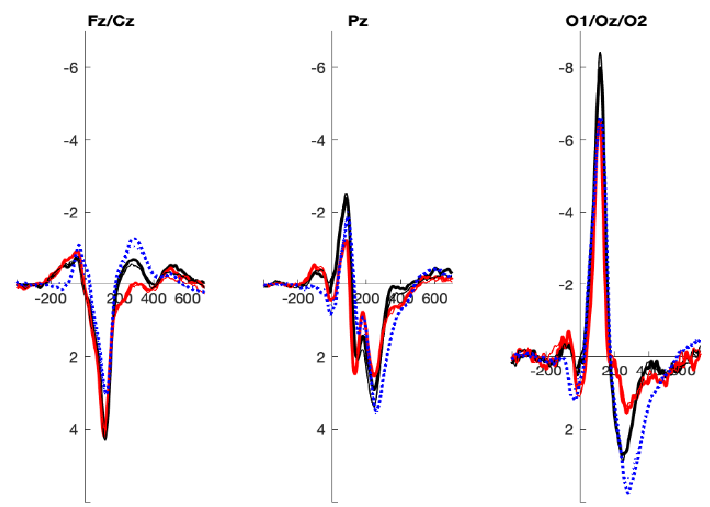
Figure 2. Waveforms of eye-blink-evoked potentials evoked at anterior, parietal, and occipital leads. ERPs are presented for standing (dotted blue), walking on meadow (black solid), and mastering the obstacle course (red solid). Data from the first block (bold) and the second block (thin) are superposed. This demonstrates that there was hardly any difference in the eye-blink-related activity across blocks. By and large, waveshapes and morphologies resemble onset-evoked visual ERPs.